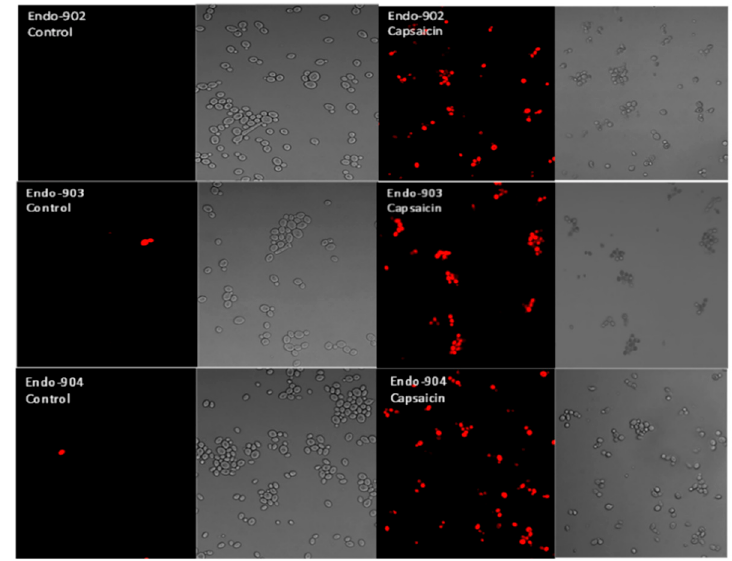
Figure 4. Confocal scanning laser microscopy (CSLM) images of endodontic C. albicans cells (Endo) treated with Capsaicin (MIC) (right panel) and untreated control cells (left panel). To observe membrane damage, cells were stained with propidium iodide (red signals).